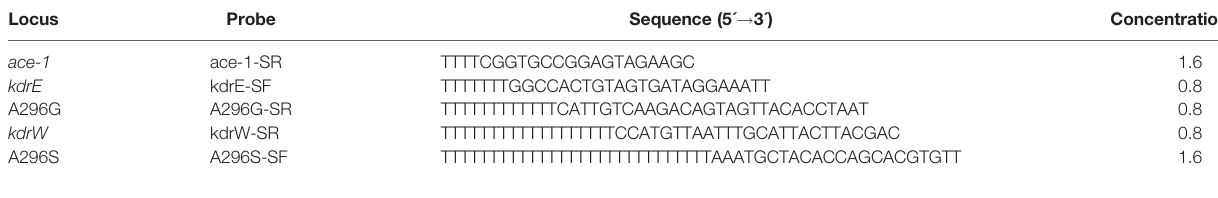
TABLE 2 | SNaPshot extension primers for the detection of multiple insecticide resistance genes mutations in An. gambiae . Locus